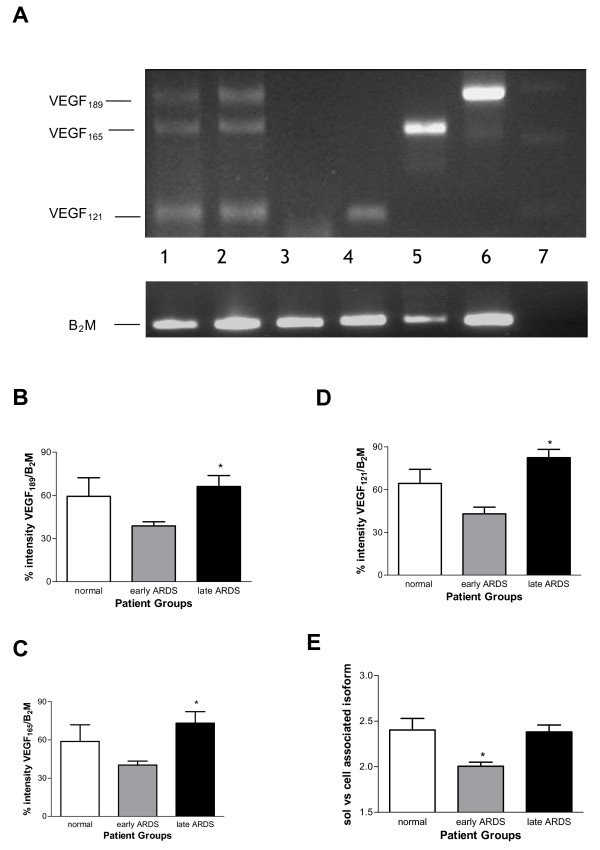
A): Representative RT-PCR gel for human VEGF isoforms in normal, early and later ARDS, lanes as follows: (1) early ARDS, (2) later ARDS, (3) negative control, (4,5,6) sequenced positive controls (VEGF121, VEGF165 and VEGF189 respectively), (7) 100 kb ladder (bottom marker denotes 100 bp, top marker 300 bp). B-E): Semiquantitative densitometry of (B) VEGF189, (C) VEGF165, (D) VEGF121 relative to β-microglobulin (B2M) in normal, early and later ARDS (*p < 0.05 late versus early ARDS), (E) ratio of soluble (VEGF121, VEGF165) to cell-associated (VEGF189) isoforms (*p < 0.05 early versus normal and later ARDS). Data are plotted as means with bars denoting standard errors (ANOVA with post-hoc Bonferroni) for B-E).